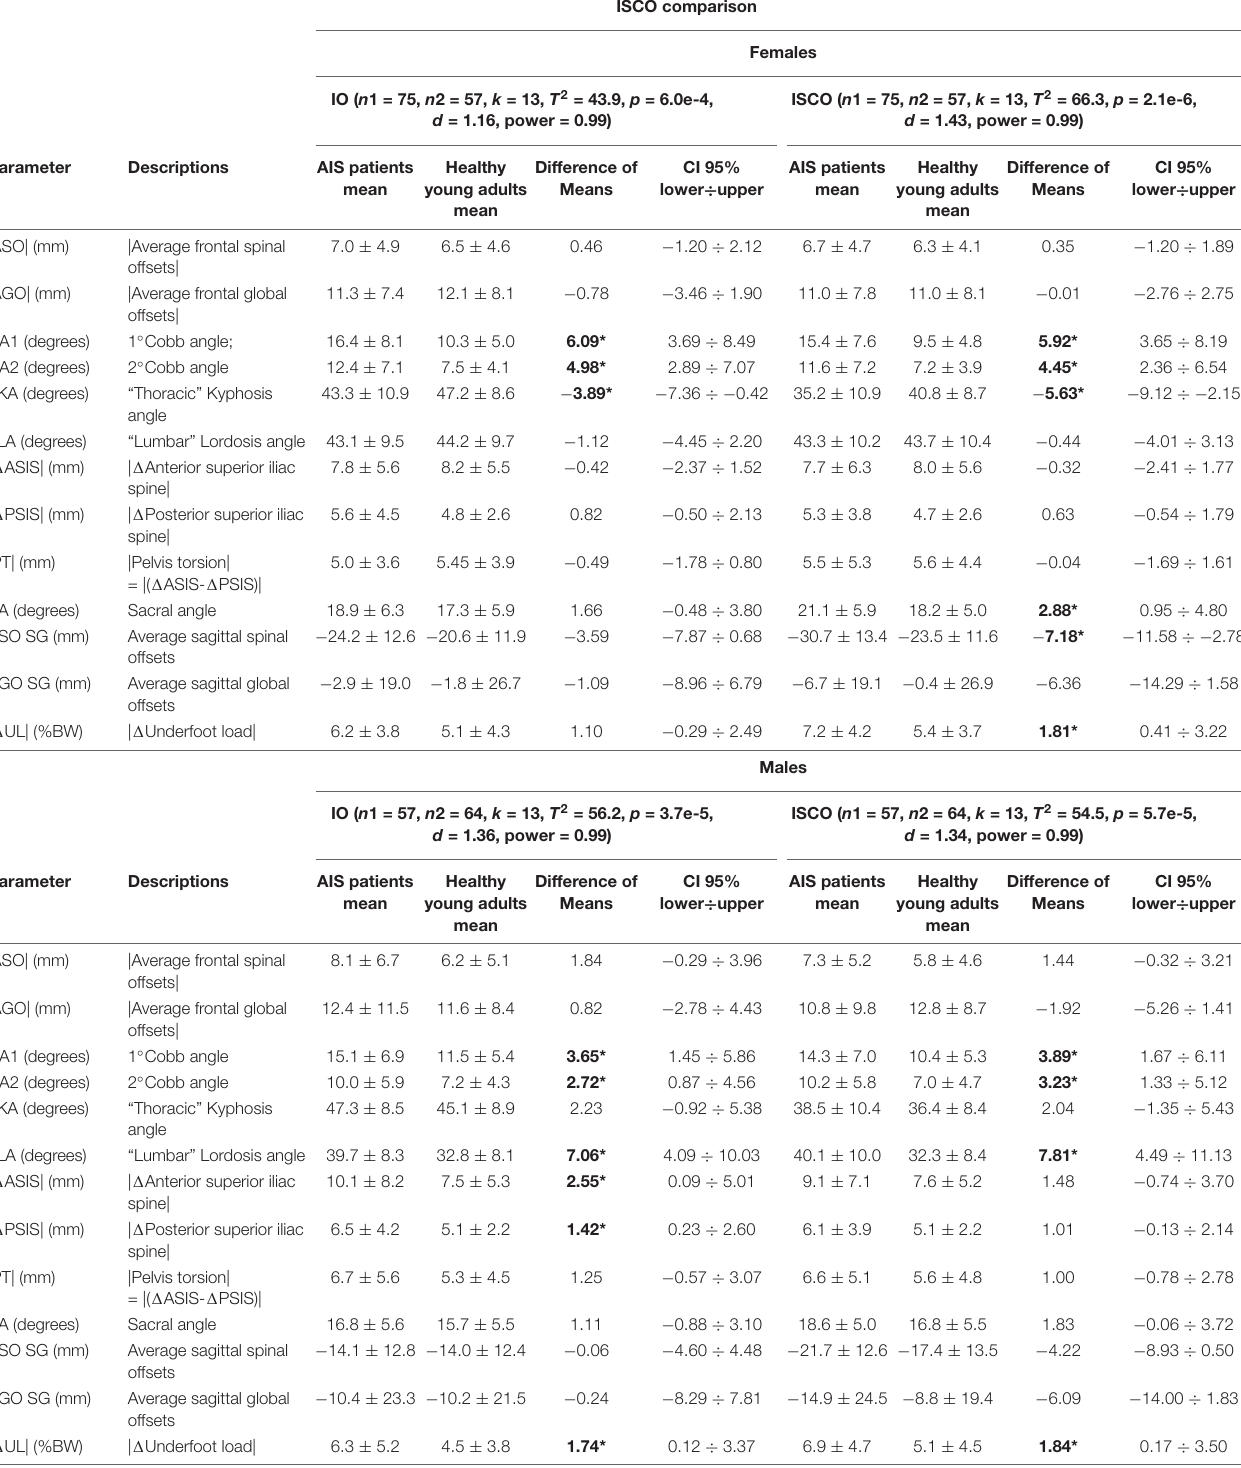
TABLE 5 | Per-gender AIS patients vs. healthy young adults comparisons in both IO and ISCO: Hotelling T 2 tests results, 95% confidence intervals, and difference of means. Hotelling T 2 test for independent samples: AIS patients vs. healthy young adults in IO and ISCO comparison